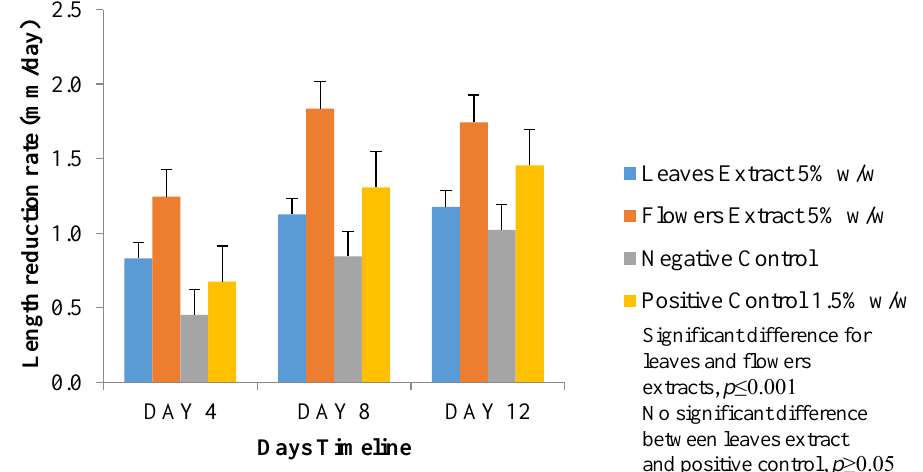
Figure 8. Wound-length reduction rate (mm/day) at day 4, 8, and 12.